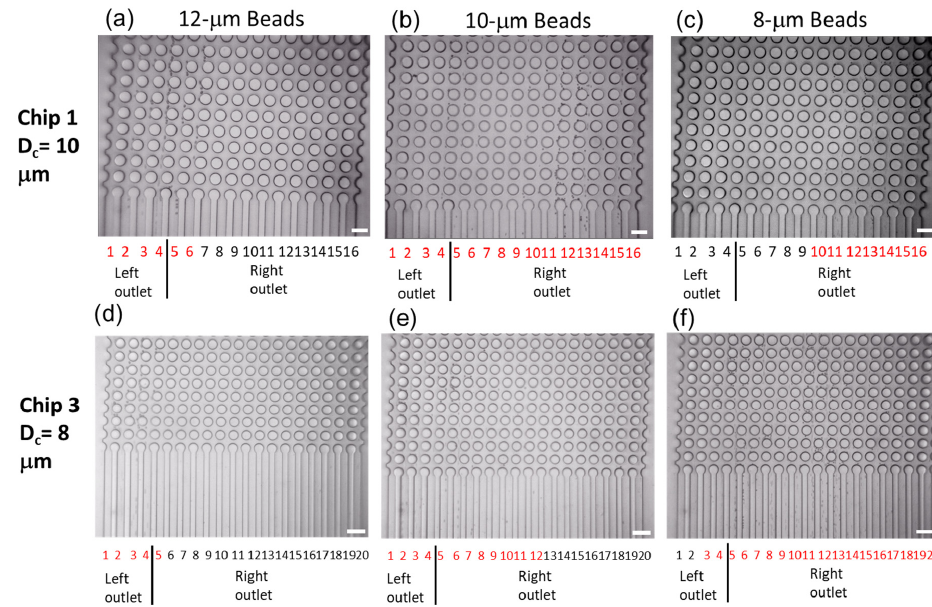
Figure 7. Images of polystyrene bead separations near outlet channels for 0.1 s (25 frames). ( a ) 12- µ m beads, ( b ) 10- µ m beads, or ( c ) 8- µ m beads separated using Chip 1 in which Channels 1–4 are connected to the left outlet and Channels 5–16 are connected to the right outlet. ( d ) 12- µ m beads, ( e ) 10- µ m beads, or ( f ) 8- µ m beads separated using Chip 3 in which Channels 1–4 are connected to the left outlet and Channels 5–20 are connected to the right outlet. The outlet channel numbers in red indicate sorted particles that were observed in the outlet channel. The scale bars are 100 µ m.